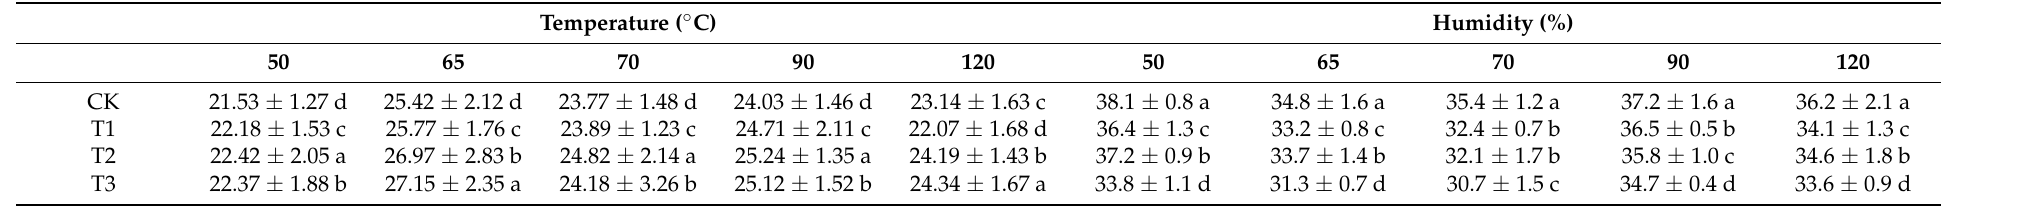
Table 1. The temperature and humidity under four training systems.